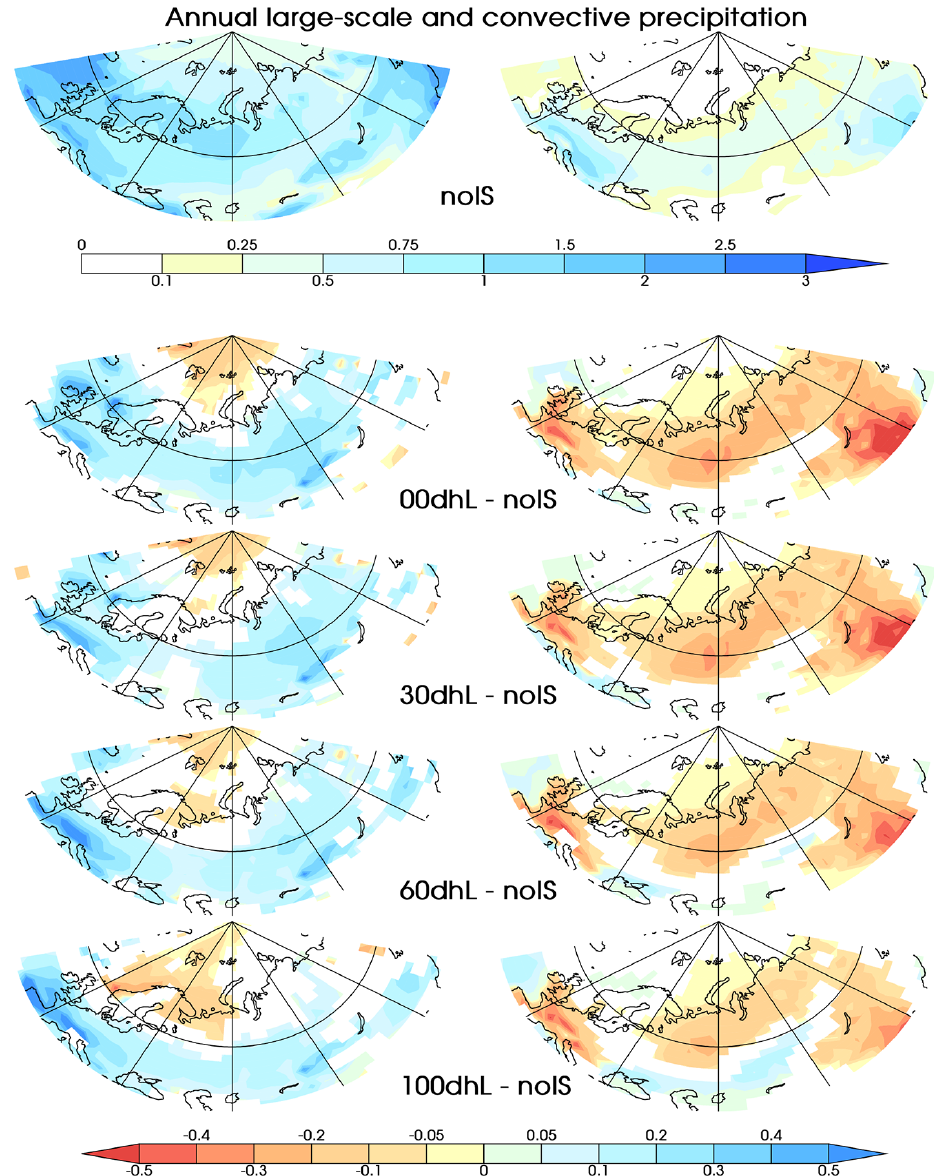
Figure 7. Large-scale (left panels) and convective (right panels) annual precipitation without LIS (noIS experiment, top panels), and anoma- lies of large-scale and convective precipitation between the xx dhL and noIS experiments. The statistical significance of the patterns of temperature anomalies has been checked using a two-sided Student- t test with a p value = 0.05. The white shading indicates areas where the anomaly is not